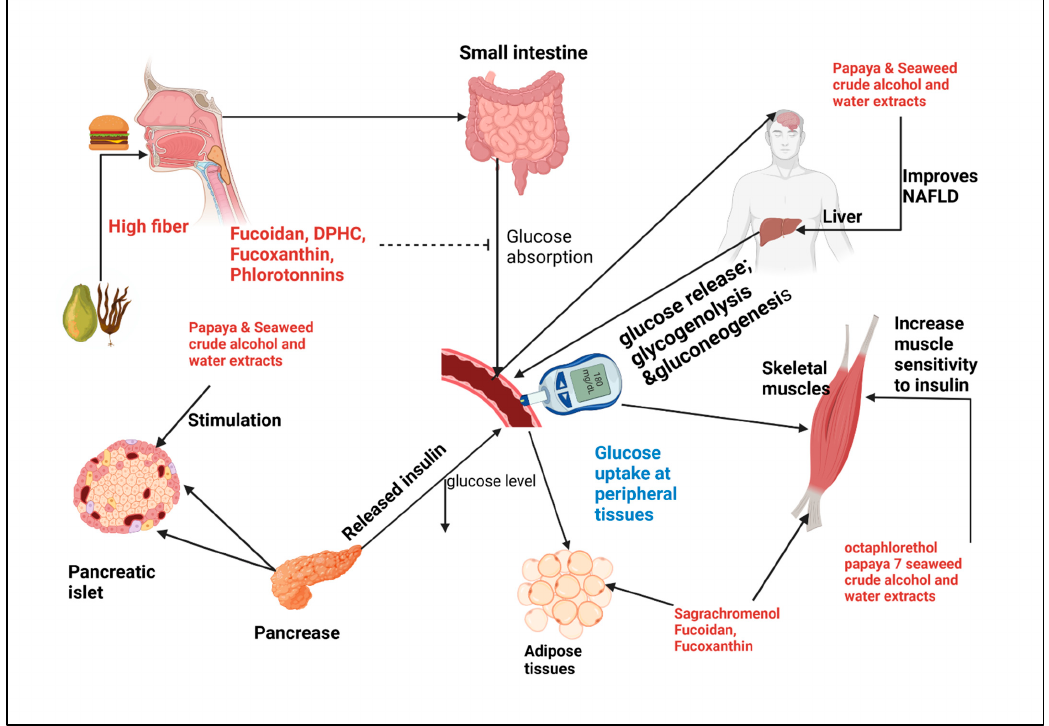
Figure 1. Schematic representation of papaya and seaweed antihyperglycemic mechanisms. At di- gestion consumption of high fiber Papaya and seaweed slows blood sugar increase, intestinal ab- sorption inhibitor of α -amylase and α -glucosidase are inhibited by fucoidan, DPHC, Fucoxanthin, phlorotannin. In the peripheral organs insulin mediated uptake is activated by Octaphlorethol, Fu- coidan, sagrachromenol, alcohol and water crude extracts. Crude extracts stimulate pancreatic islet and improve hepatic NAFLD.